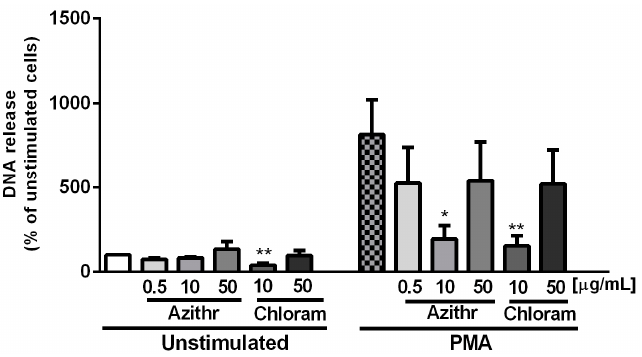
Figure 4. Effect of azithromycin and chloramphenicol on NET release. 100 nM phorbol 12-myristate 13-acetate (PMA) was added to stimulate the release of NETs, neutrophils treated with antibiotics without stimulation served as the negative control ( n = 6).